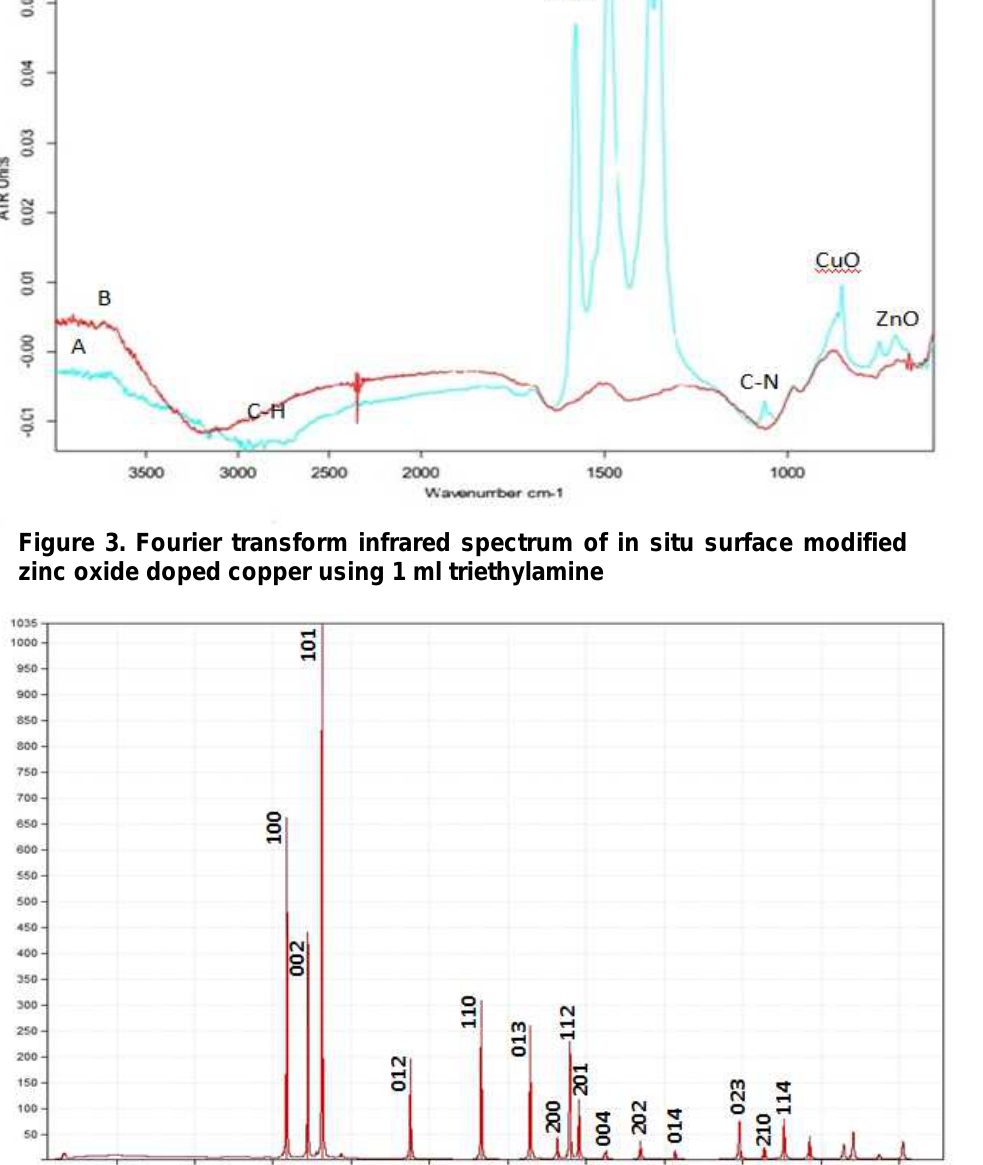
Figure 4. X-ray diffraction patter of in situ surface modified zinc oxide doped copper using 1 ml triethylamine Table 2 . Lattice parameters of surface modification copper:zinc oxide hybrid nanoparticle